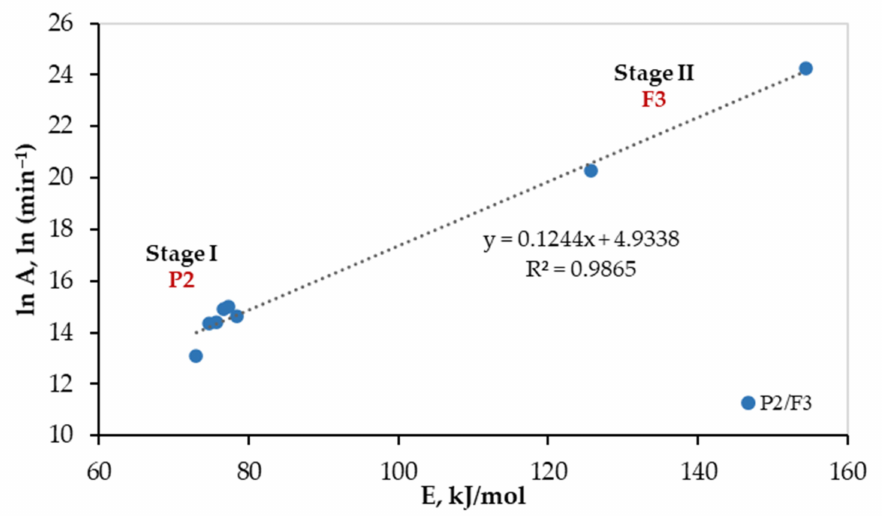
Figure 5. Linear fitted curve for the compensation effect.